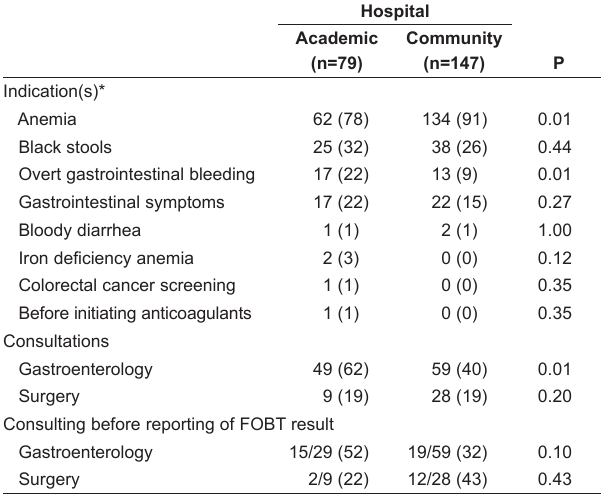
endoscopic findings* among individuals who underwent one or more endoscopic evaluation(s), stratified according